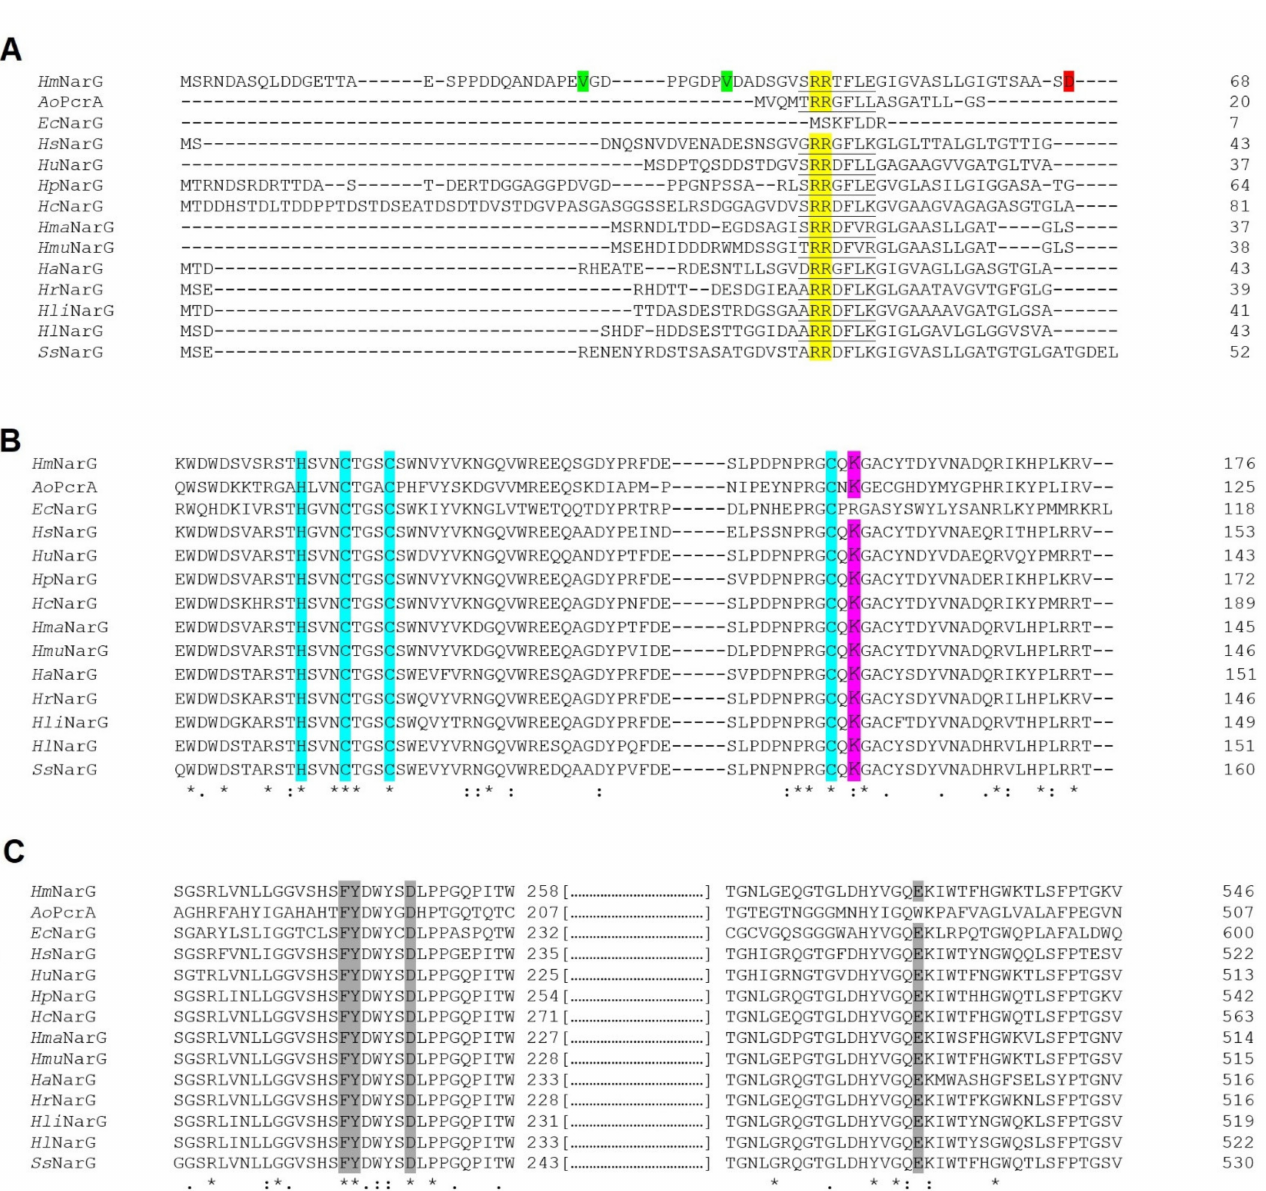
yellow, hypothetical start codons and the first amino acid of mature of Haloferax mediterranei NarG are shown in green and red, respectively. ( B ) Metal-coordinating regions of FS0 cluster. His and Cys residues involved in FS0 cluster coordination are highlighted in cyan whereas Lys involved in a possible electron transfer pathway between FS0 and MoCo cofactor are rendered in magenta. ( C ) NarG active site. The conserved residues involved in catalytic mechanism are highlighted in